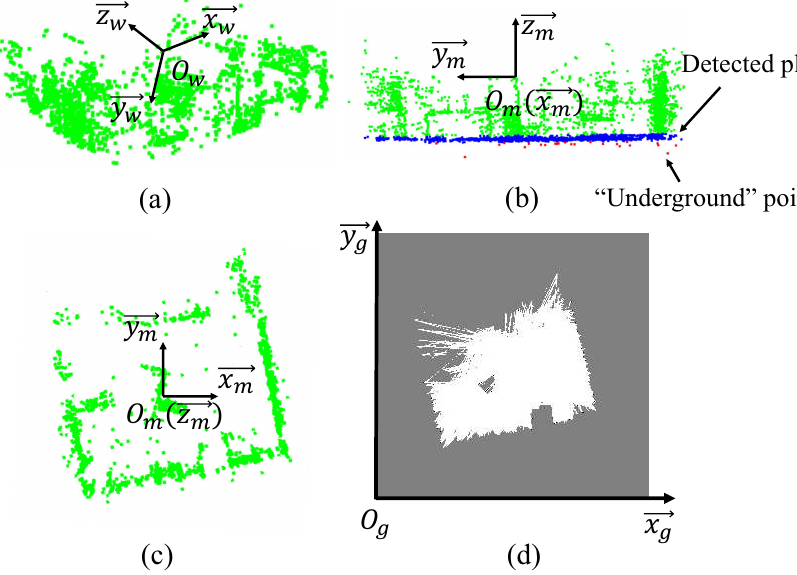
Figure 2. An example of 2D structure extraction on the EuRoC dataset [34]: ( a ) the raw point cloud built by monocular SLAM on the Euroc dataset, ( b ) floor plane detected by RANSAC and the new map frame O m , ( c ) top view of the point cloud map, ( d ) extracted 2D grid map. The black, gray and white pixels represent the obstacle, unknown, and free grids,